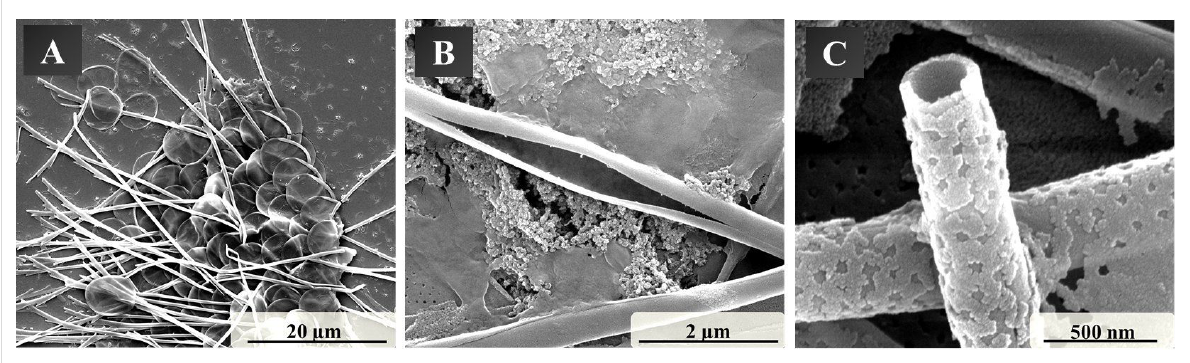
Figure 1: Scanning electron micrographs of the skeletal elements of Mallomonas caudata with an overview of spikes and shields (A), a broken spike (B), and a view into a broken spike (C).